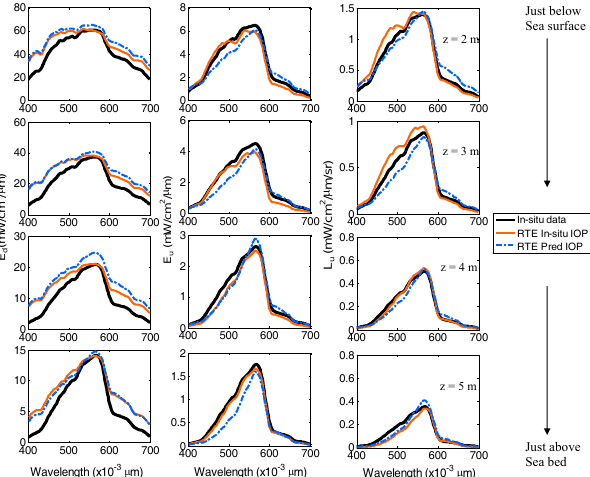
Figure 12. Spectral comparisons of the simulated and measured underwater light fields ( E d , E u and L u ) for four discrete depths in moderately turbid waters off Point Calimere (St-5). The black colour represents the measured data, orange colour represents re- sults from the present RT model using in situ IOP data, and the blue colour represents results from the present RT model using the pre- dicted IOPs from the remote-sensing reflectance data.